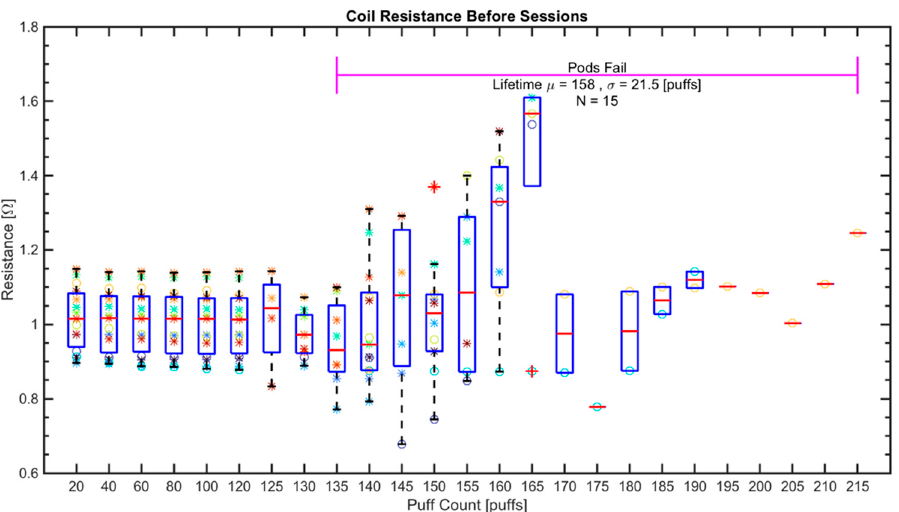
Figure 3. Coil resistance over time (no. puffs) starting with brand new full pod until failure for the N = 15 pods tested in this study. Data is represented as scatter plot where each pod is represented by a different marker color. Data is also represented with a box plot where the horizontal red marker indicates the group mean and a red plus marker indicates the corresponding data point is an outlier.